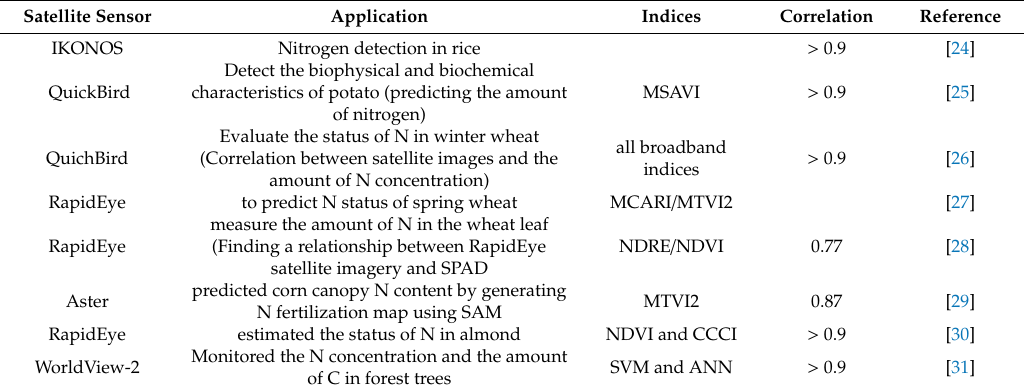
Table 1. Summary of the reviewed research works on satellite sensors used in nitrogen management in agriculture.